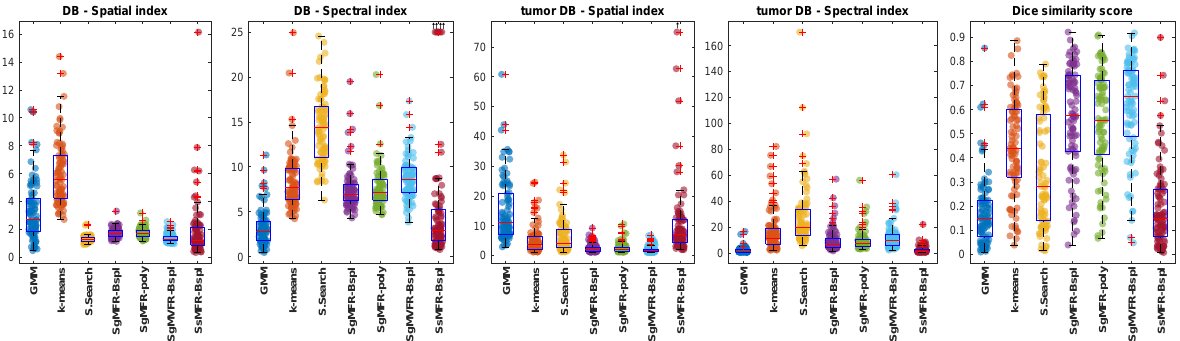
Figure 3. Boxplots for each metric per method. Note that SsMFR-Bspl method gives few outliers out of reach (order of 10 13 ) on the DB spectral index, and one outlier of 135 for tumor DB spatial index. These values are shifted in the displayed range and exhibit a top